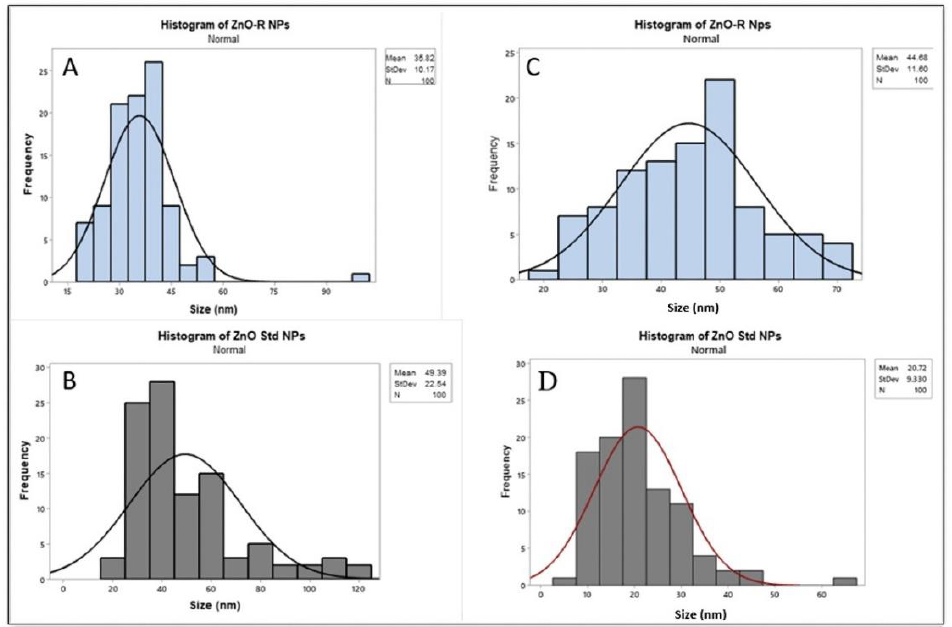
Figure 2. Histogram from the SEM of ( A ) ZnO-R NPs and ( B ) ZnO Std NPs. Histogram from the TEM of ( C ) ZnO-R NPs and ( D ) ZnO Std NPs.